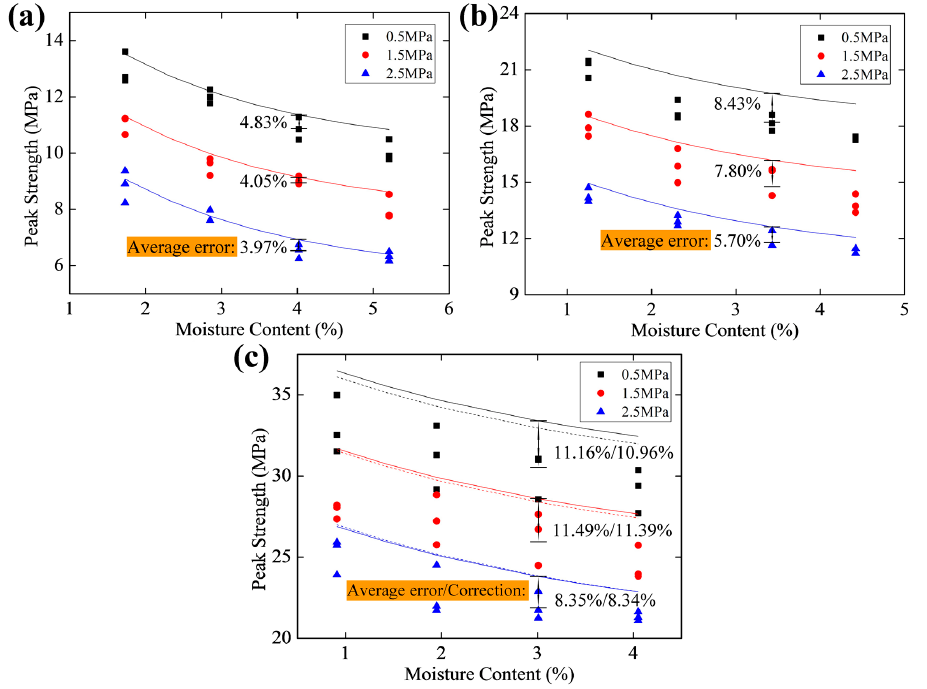
Figure 12. Relationship between peak strength and moisture content: ( a ) Songzao; ( b ) Pingdingshan; and ( c ) Tashan.